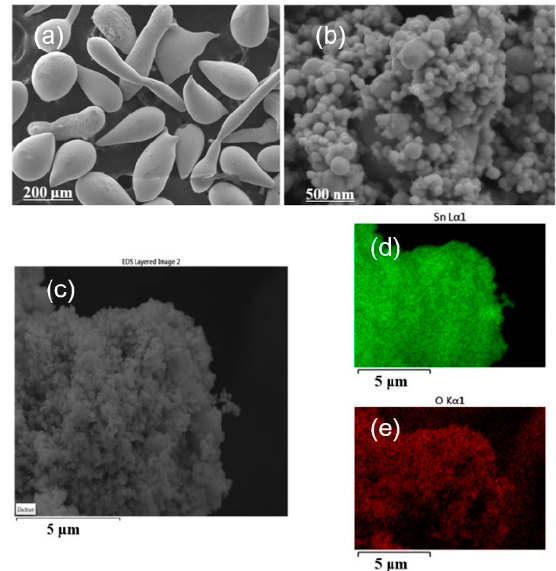
Figure 6. FESEM (Field-Emission Scanning Electron Microscope) images of ( a ) micro-Sn, and ( b , c ) nano-Sn. EDX composition mapping of nano-Sn: ( d ) tin and ( e ) oxygen.